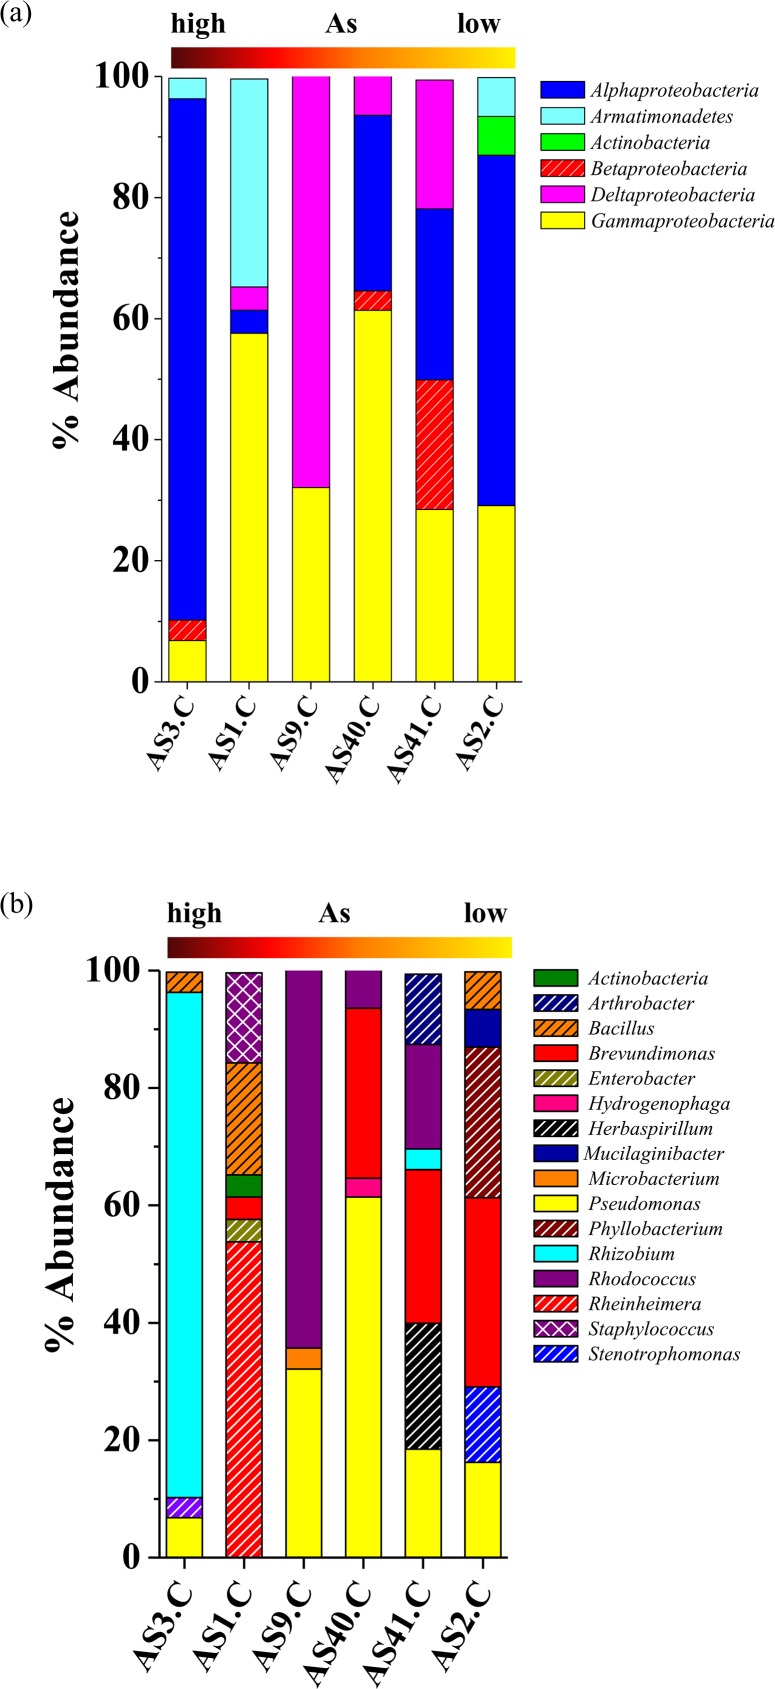
Distribution of major phylogenetic groups of isolated bacteria.Abundance of bacterial groups is plotted with respect to their affiliation at (a) phylum level and (b) genus level. The horizontal bar indicates gradient of As concentrations as detected in six samples.